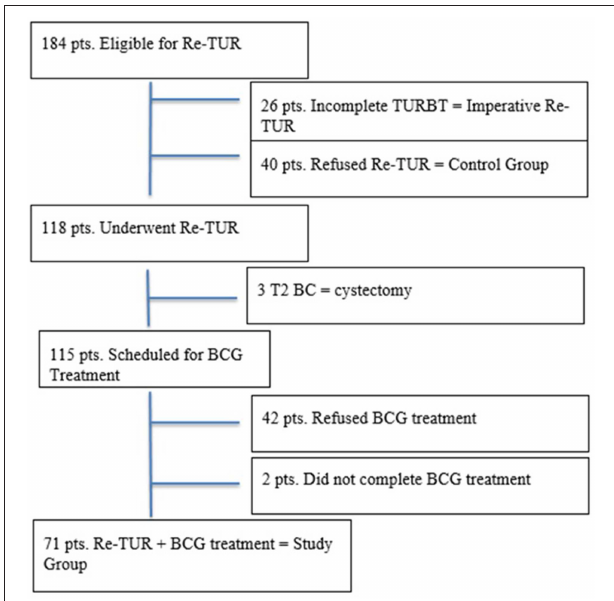
FIGURE 1 | Flowchart patients selection.